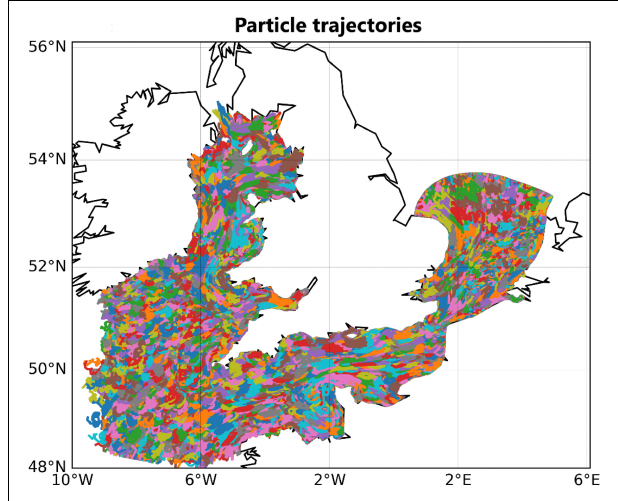
FIGURE 2 | Particle trajectories during September 10–17, 2019, which were used for an application of the prediction scheme.